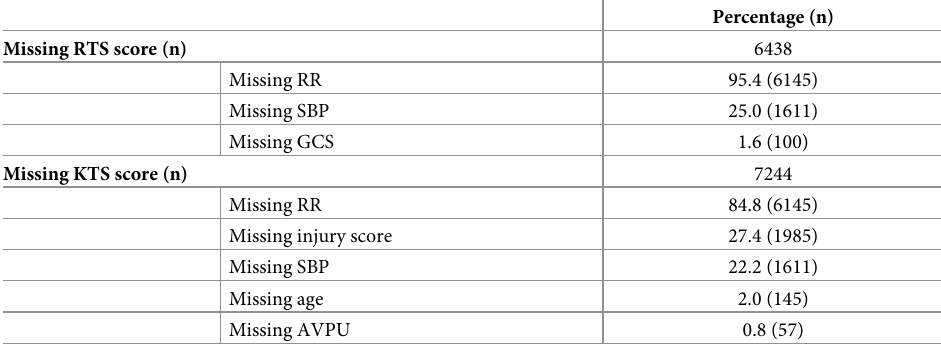
Table 3. Missing RTS and KTS